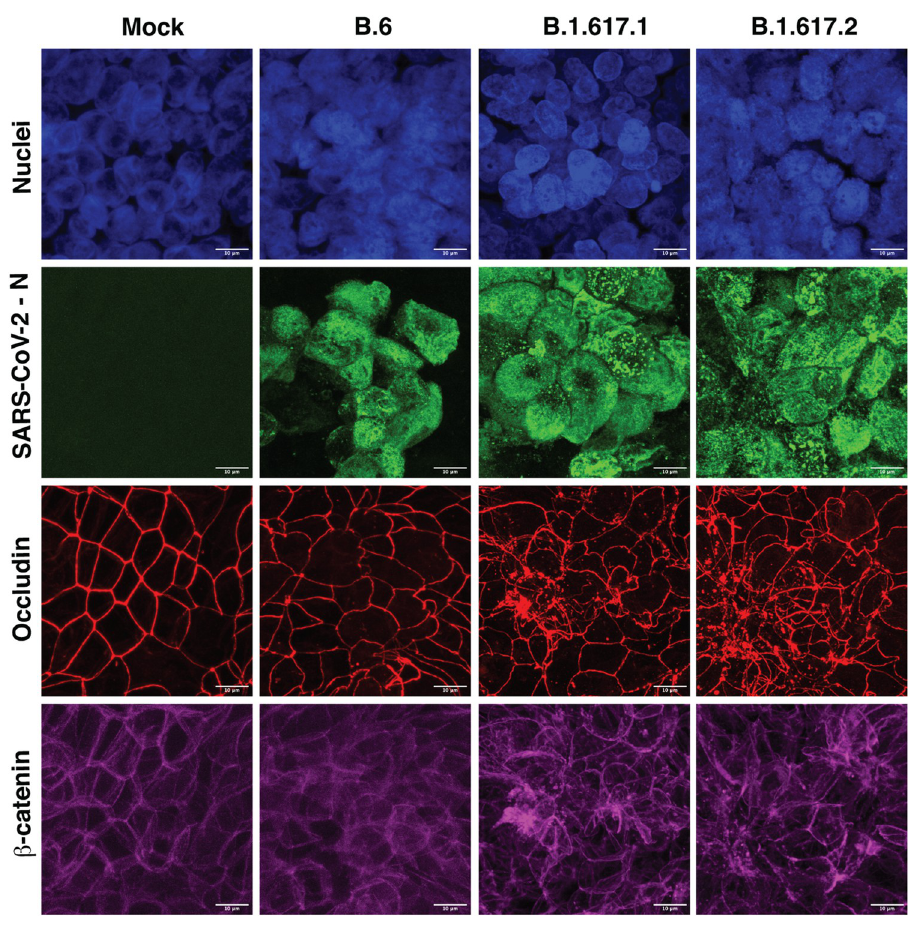
Fig 2. Kappa and Delta variants of SARS-CoV-2 disrupt epithelial junctions. Calu-3 cells were grown on transwell inserts and infected with indicated variants of SARS-CoV-2 at 0.3 MOI. At 48 h pi, cells were fixed and stained with occludin and β -catenin antibodies. Nucleocapsid antibody was used to visualize the SARS-CoV-2 infection. Appropriate Alexa Fluor dye-conjugated secondary antibodies were used for visualization. Nuclei were stained with DAPI. Images were captured at 100X magnification. Images were analyzed using cellSens software and Z-projection at maximum intensity images are shown in the figure. Scale bar is 10 μ M.